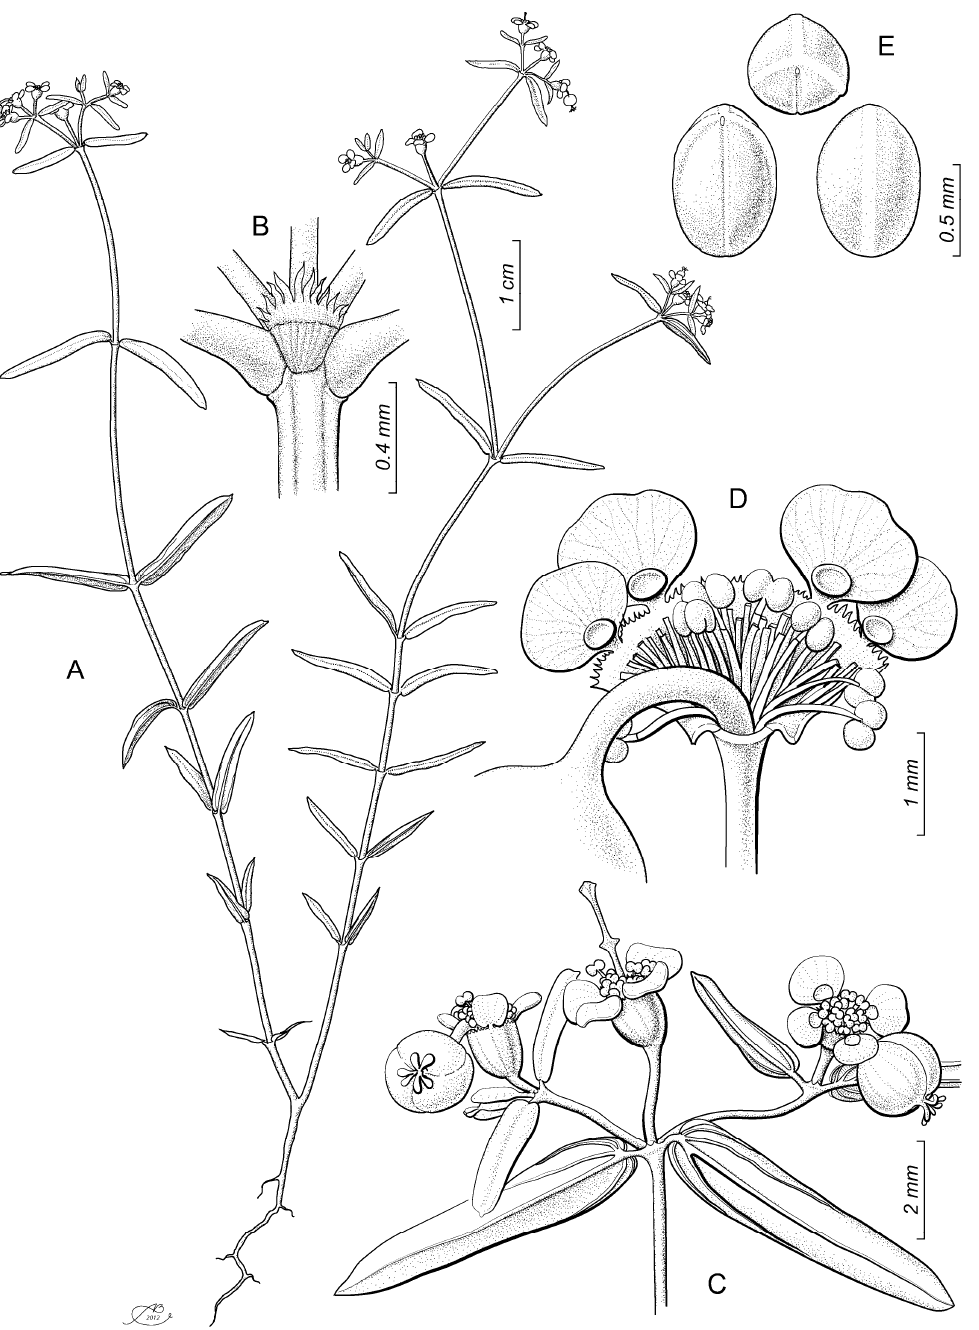
Figure 1. Euphorbia marciae. Hinton et al. 9357, isotype (NY).